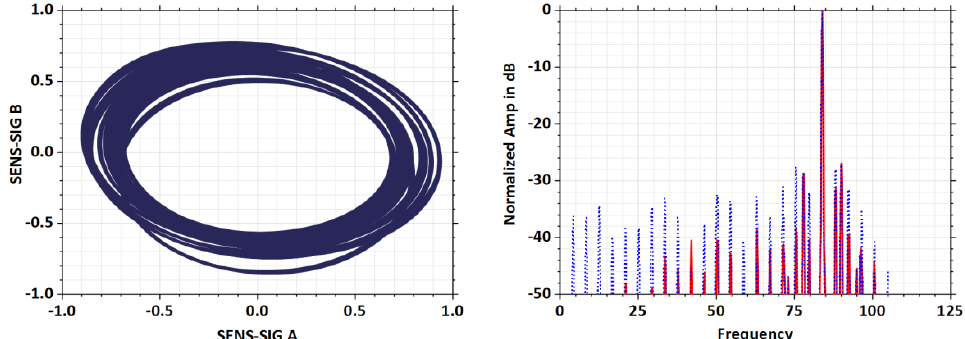
Figure 26. Outputs of a rotor R2 (defect in